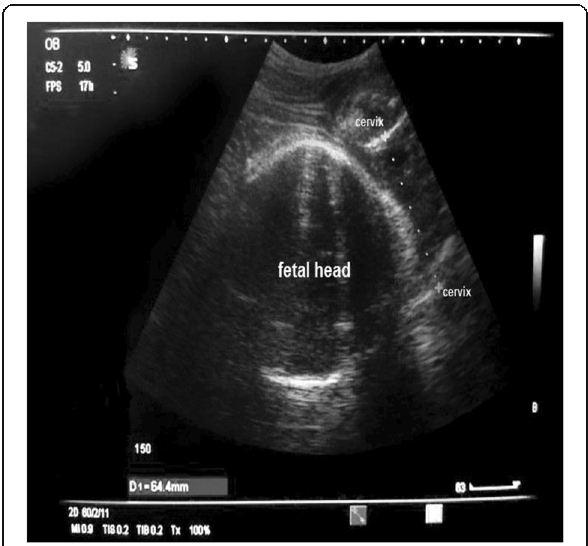
Fig. 1 Cervical dilatation measured by TPUS. Cervical dilatation is 64.4 mm measured transperineally in the anteroposterior plane from the inner part of the cervical tissue anteriorly and the inner part of the cervical tissue posteriorly